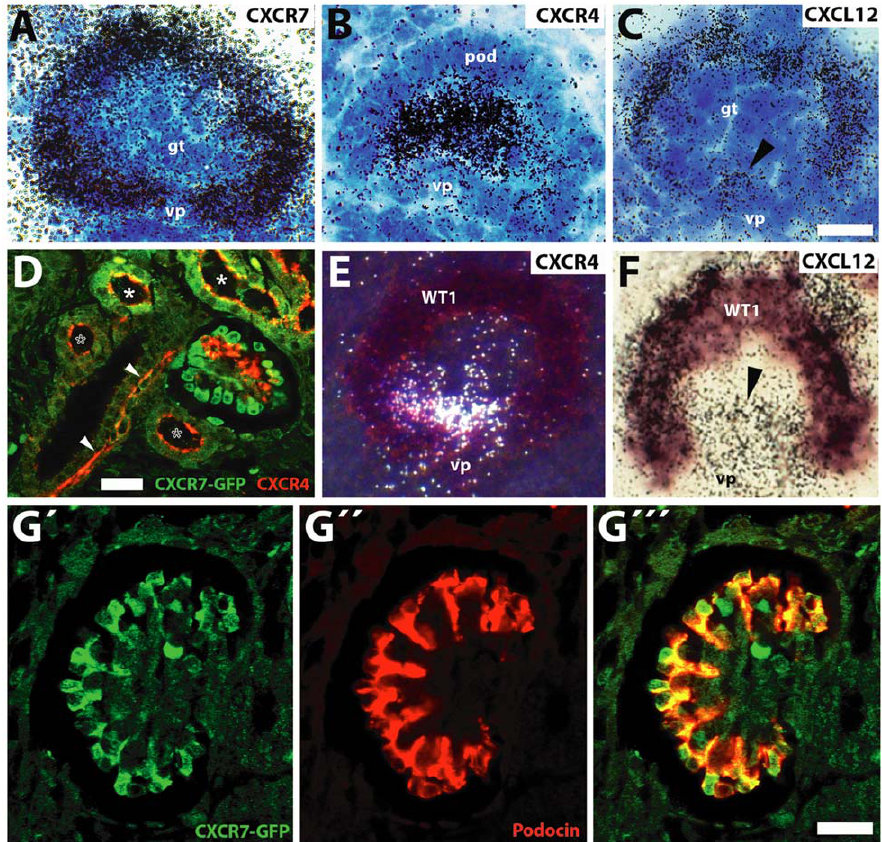
Figure 3. CXCR7, CXCR4, and CXCL12 expression in mature glomeruli. (A–C) Brightfield micrographs of cresyl violet stained mature glomeruli (E16.5) after hybridization with 35 S- labeled probes for CXCR7, CXCR4, and CXCL12. ( A,B ) Signals for CXCR7 are restricted to the podocyte layer whereas CXCR4 is restricted to the center of the glomerulus. ( C ) CXCL12 is detected both in the podocytes and in the area of the vascular pole (vp, arrowhead). (D–E) Mature glomeruli after dual in situ hybridization with 35 S labeled probes for CXCR4 (D), CXCL12 (E), and a DIG-labeled probe for podocyte marker WT1 (D,E). ( D ) The darkfield micrograph reveals CXCR4 labeling (white signals) close to the vascular pole but not in WT1 stained podocytes of the visceral blade of Bowman’s capsule. ( E ) The brightfield image shows labeling for CXCL12 mRNA (black grains) in the WT1 positive podocyte layer and in the WT1 negative area of the vascular pole (vp, arrowhead). (F–G) Confocal images of dual immunofluorescent stainings for GFP/CXCR4 (F) and GFP/podocin (G) in E16.5 BAC transgenic mice expressing EGFP under the control of the CXCR7 promoter. ( F )